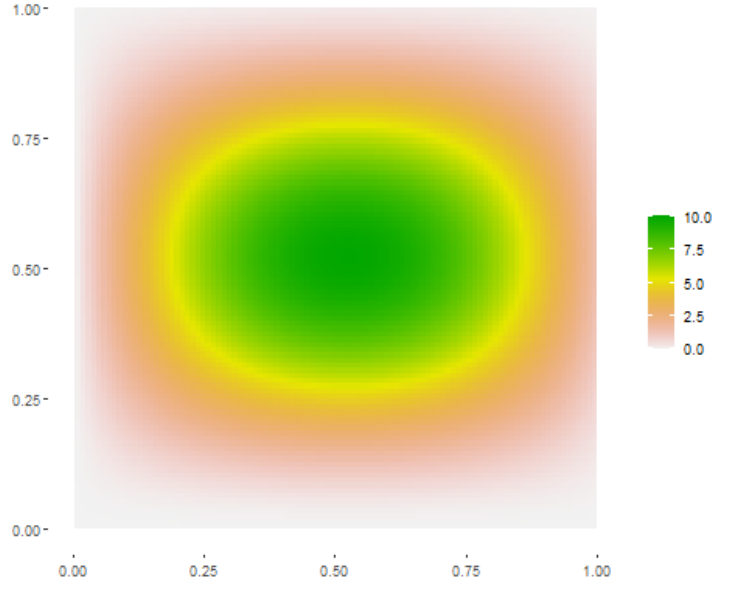
Figure 1. Map of the artificial surface adopted to generate the finite spatial populations of